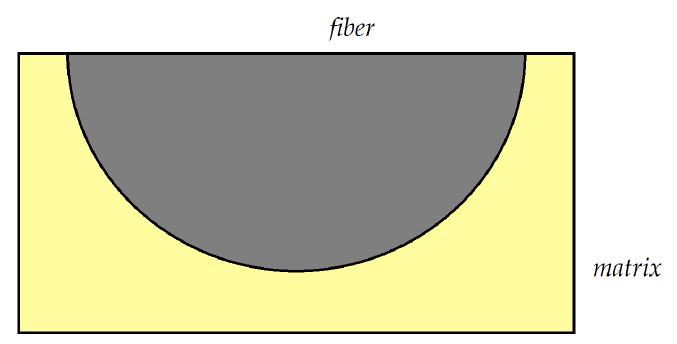
Figure 6. Finite element model 1 for a RUC.